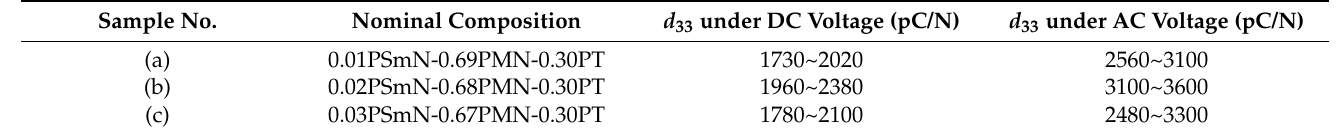
Table 1. The piezoelectric coefficient d 33 of xPSN-(0.7 − x)PMN-0.3PT single crystals.